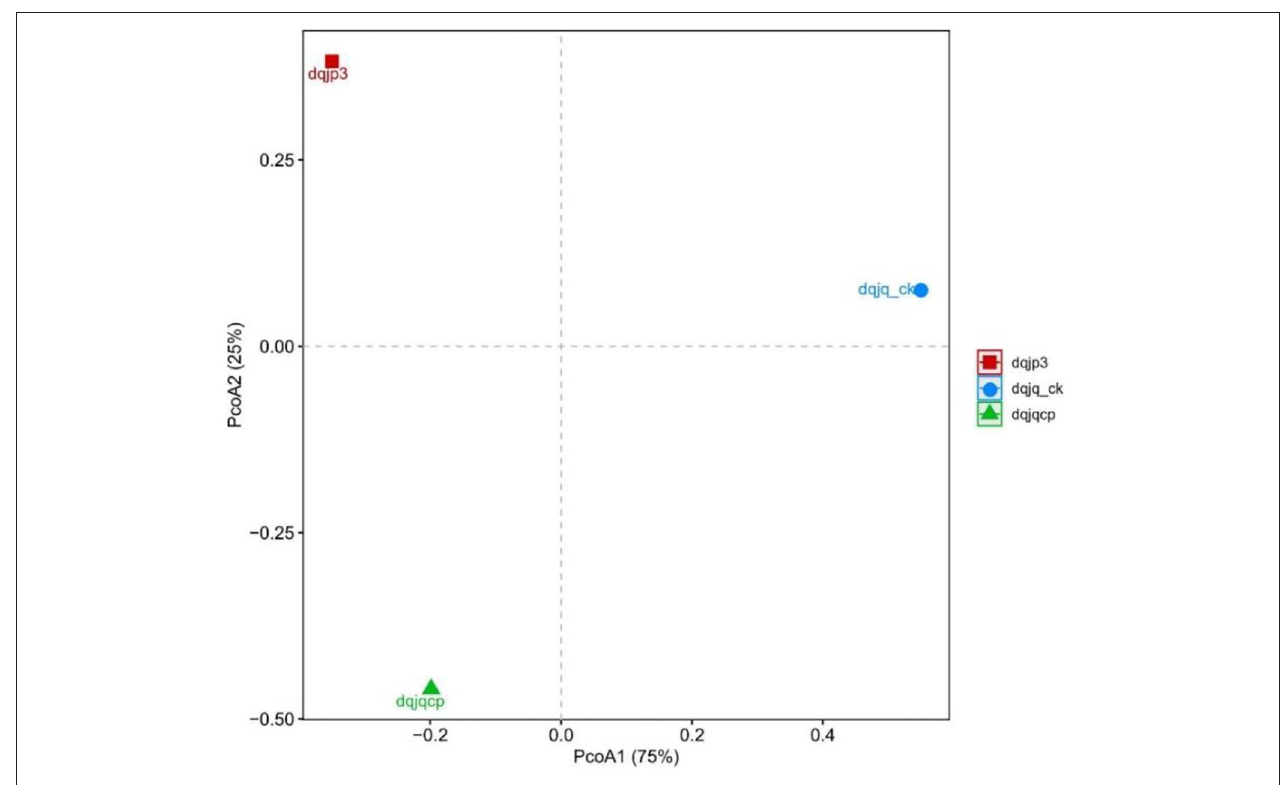
FIGURE 4 | PCoA plot based on the 16S rDNA sequences from three